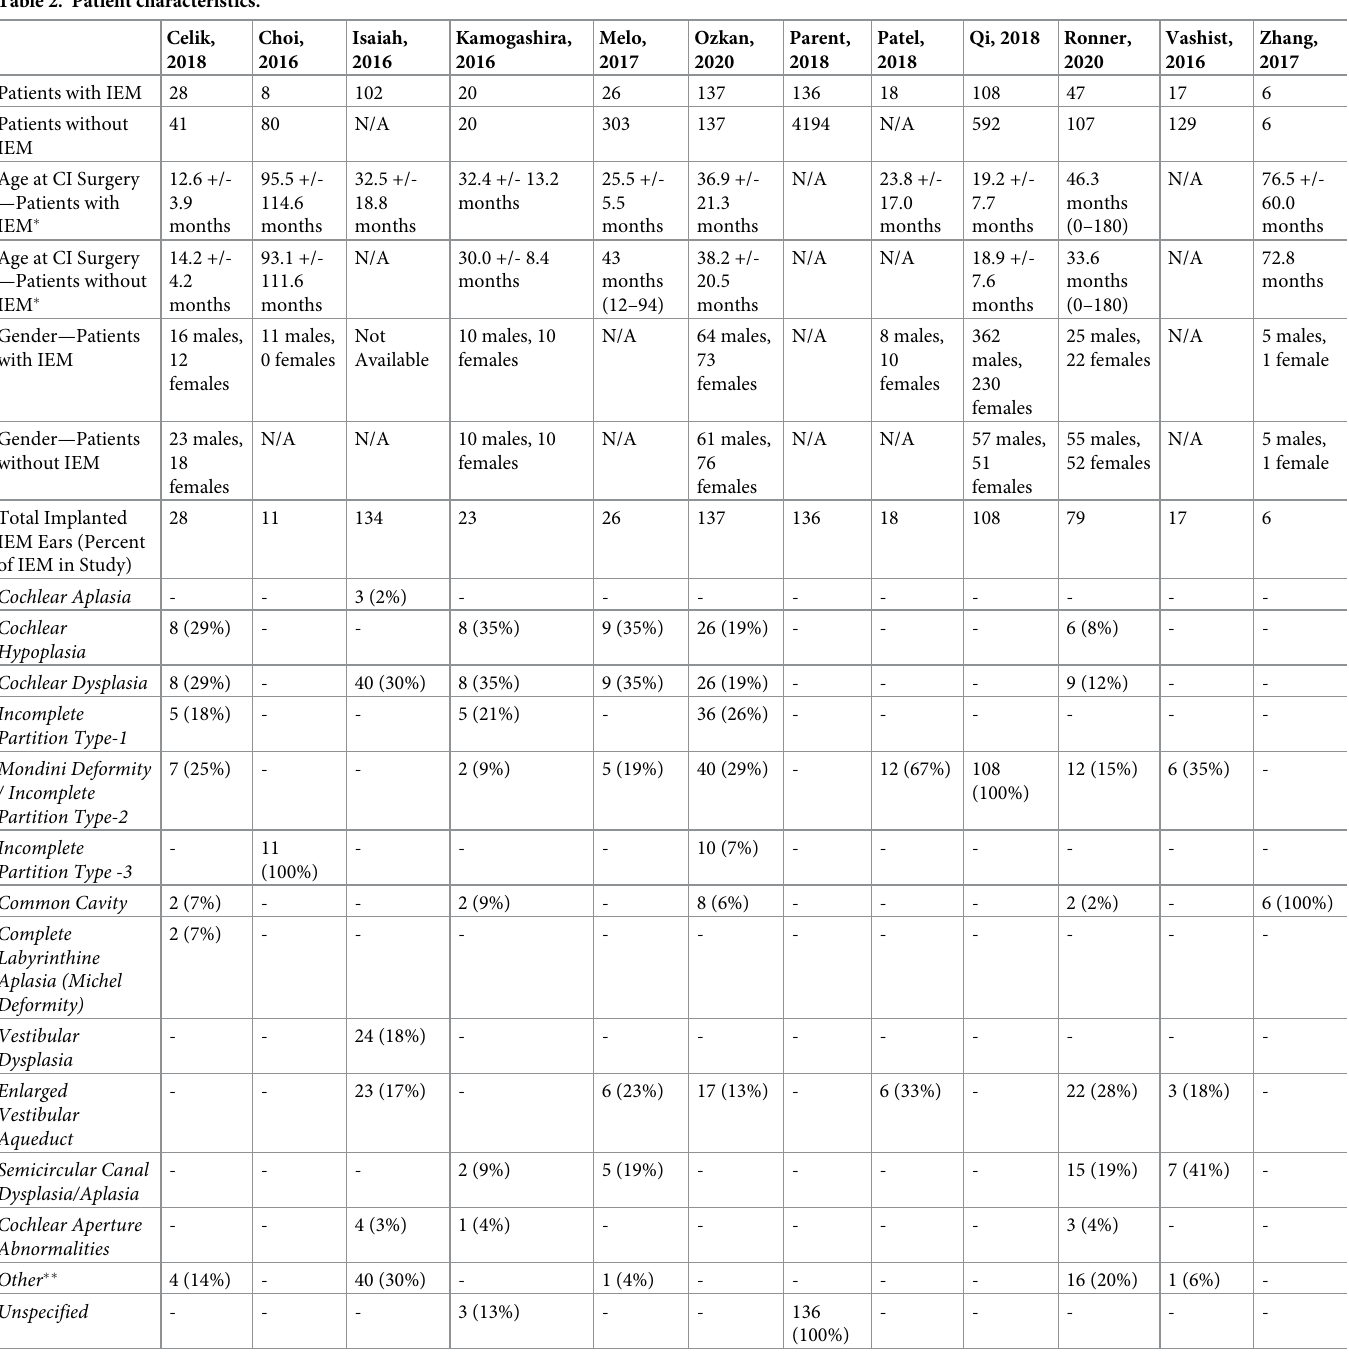
Table 2. Patient